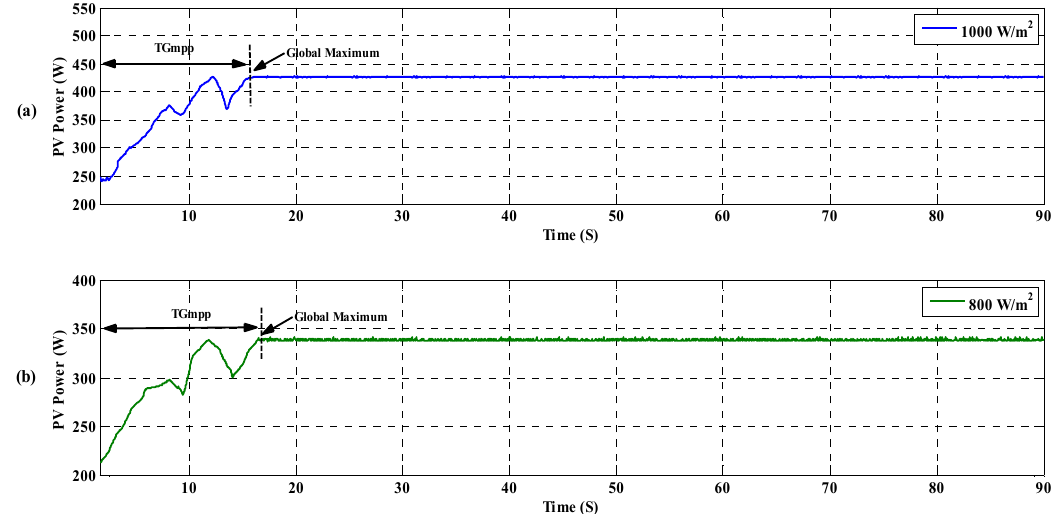
Figure 27. PV output power for the scenario in Figure 26 for irradiations of ( a ) 1000 W/m 2 and ( b ) 800 W/m 2 .